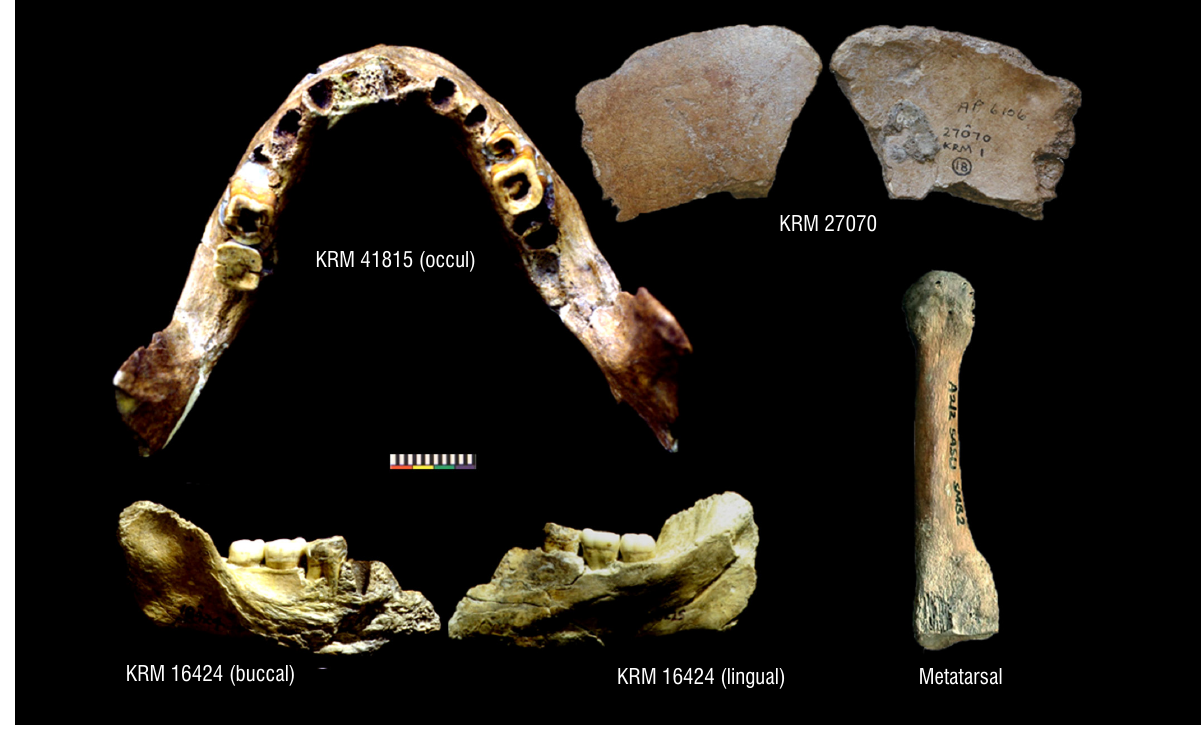
Figure 2: Selected Homo sapiens specimens from Klasies